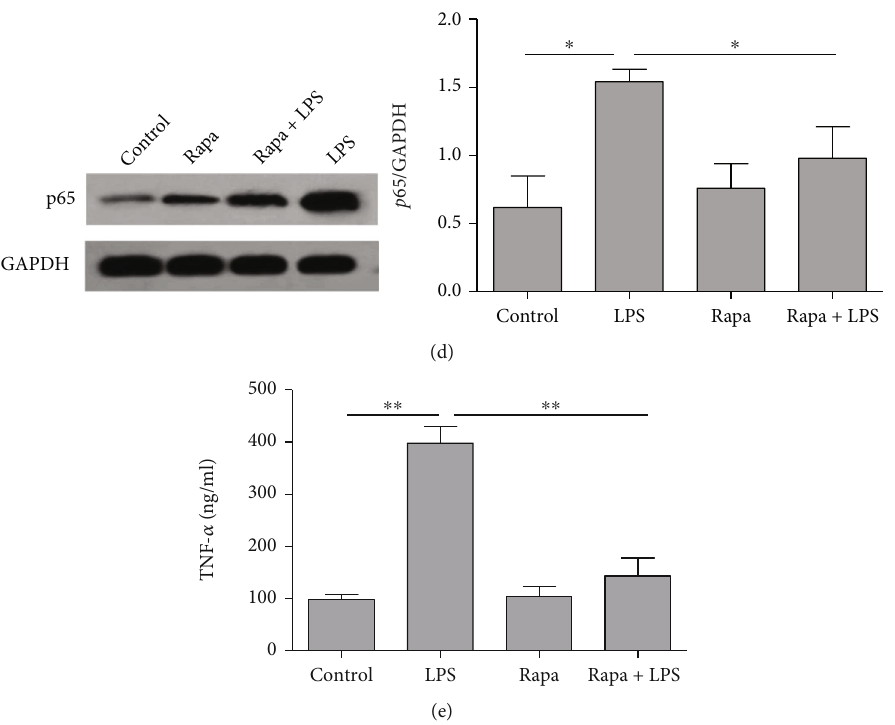
Figure 4: Rapamycin inhibits p65 nucleus translocation and TNF- α secretion both in vivo and in vitro . Mice were treated as the same in Figure 1 for 7 days. (a) The expression of p65 in colon tissue was detected using IHC staining ( × 100). (b) The expression of p65 in colon tissue was detected using western blot. (c) The expression of TNF- α from colon tissue was detected by ELISA ( n = 5 per group). (d) HT-29 cells were stimulated by LPS (100ng/ml) with or without rapamycin (25 μ g/ml) pretreatment for 1h. The expression of p65 was detected by western blot. (e) The expression of TNF- α from HT-29 cells was detected by ELISA. n = 3 per group; ∗ P < 0 : 05 and ∗∗ P < 0 : 01